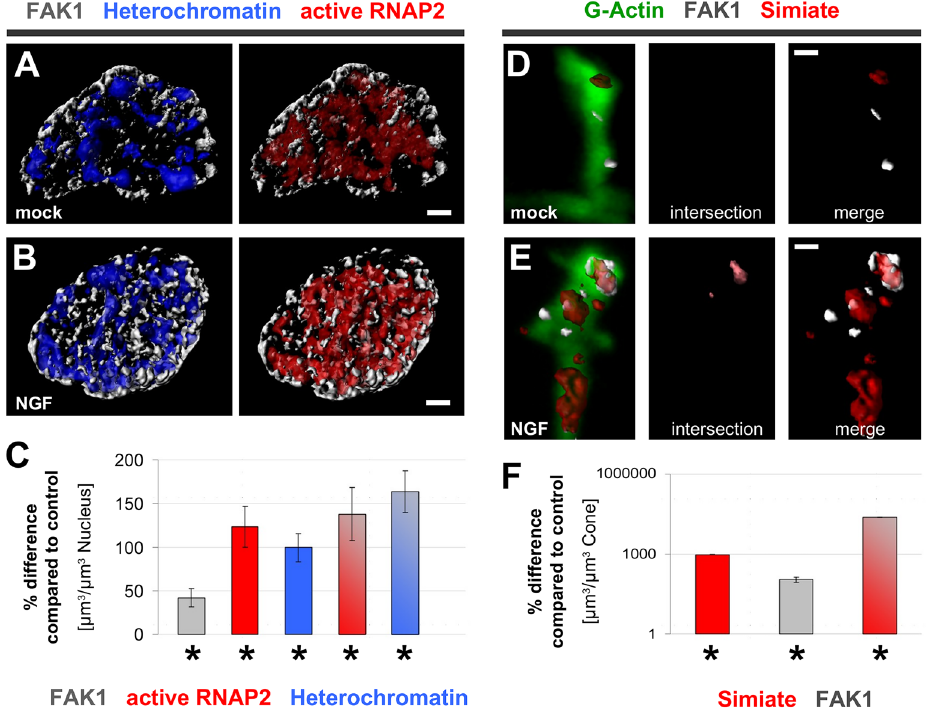
Figure 13. FAK1 and Simiate respond to neurotrophin stimulation. Following over-night treatment with NGF, div 3 primary hippocampal neurons were imaged confocally and analysed in Imaris software. Non-significant effects on FAK1, Simiate, hnRNPs and RNA as well as their colocalisations are shown in Suppl. Table 1. A – C ) NGF application influences FAK1, active RNAP2 and Heterochromatin in the nucleus of hippocampal neurons. ( A , B ) Three-dimensional reconstructions of FAK1, Heterochromatin and active RNAP2 in mock treated ( A ) and NGF treated ( B ) cells illustrate increased amounts of FAK1, RNAP2 and Heterochromatin as well as enhanced colocalisations in the nucleus following NGF application. Scale bars: 2 µm. ( C ) A quantification of FAK1 (grey), active RNAP2 (red) and Heterochromatin (blue) volumes as well as of proteins colocalising (grey-red and grey-blue) demonstrates significant increases in all protein volumes. ( D , E ) Three-dimensional reconstructions illustrate FAK1 and Simiate in dendritic growth cones following mock ( D ) or NGF ( E ) treatment (middle panel: intersection of colocalised FAK1 and Simiate, light red; right panel: FAK1 and Simiate). G-Actin labelling with DNaseAx488 served to outline the cone structure. Scale bars: 1 µm. ( F ) The volumes of FAK1 (grey), Simiate (red) as well as of colocalised FAK1 and Simiate (red-grey) are shown for dendritic growth cones. For all analyses, n equals 8. More details on the statistics can be found in Suppl. Table